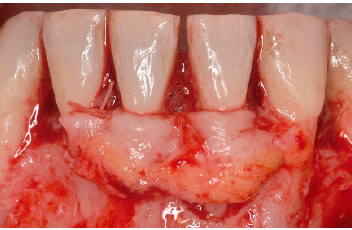
Figure 6. Following EMD application a connective tissue graft was retrieved from the patient’s palate and secured covering the denuded root surfaces.